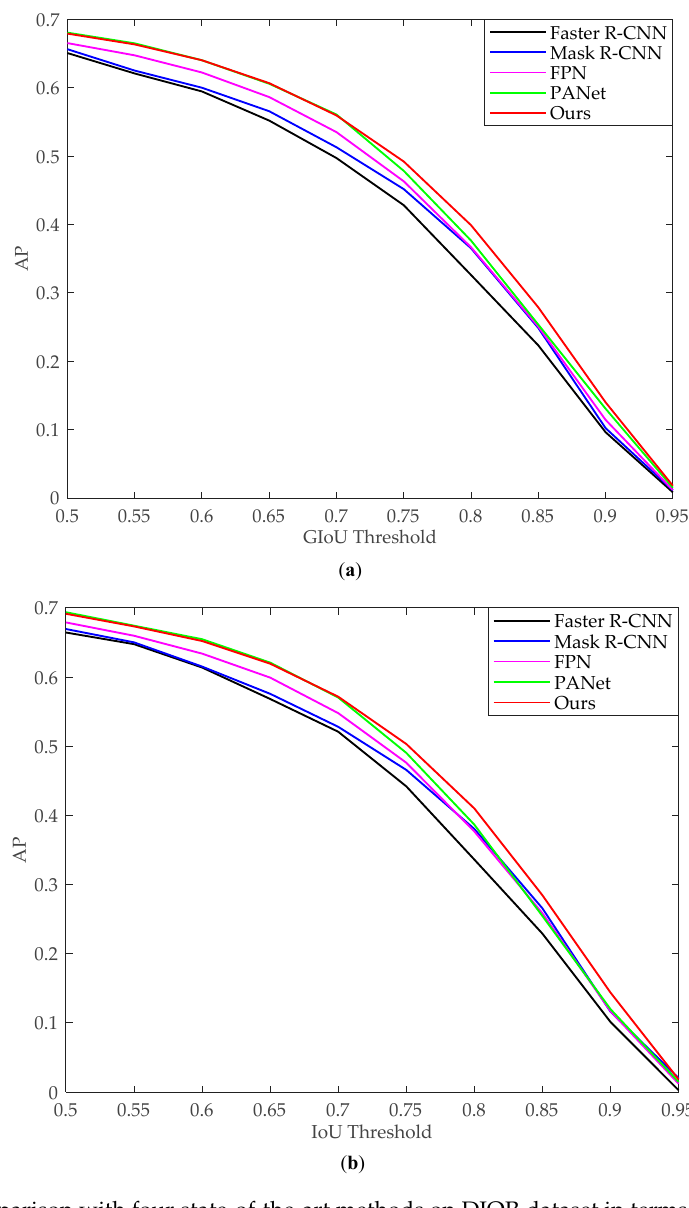
Figure 9. Comparison with four state-of-the-art methods on DIOR dataset in terms of curves of AP with different GIoU (IoU) thresholds. ( a ) GIoU threshold; ( b ) IoU threshold.